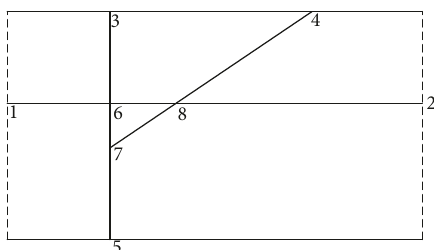
Figure 2: Sketch of fracture